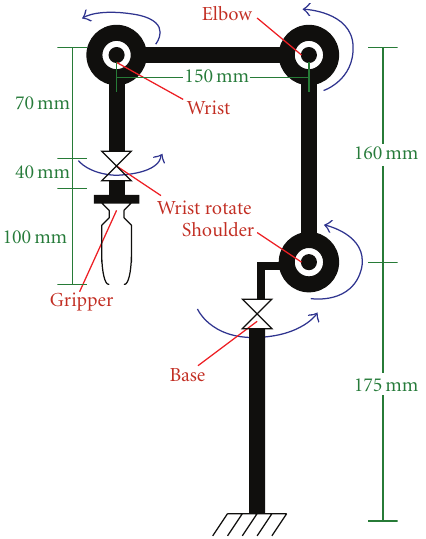
Figure 4: Arm free body diagram with the end e ff ector.